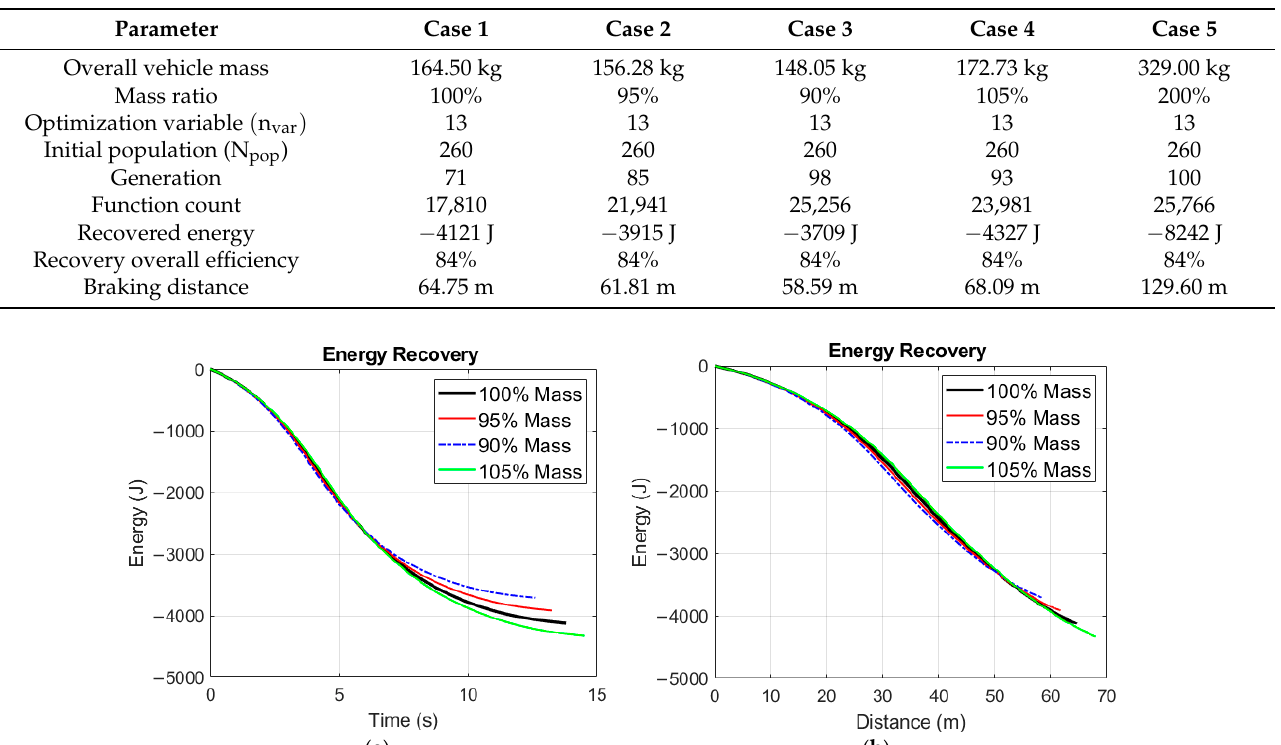
Table 3. Optimization results for mass variation.